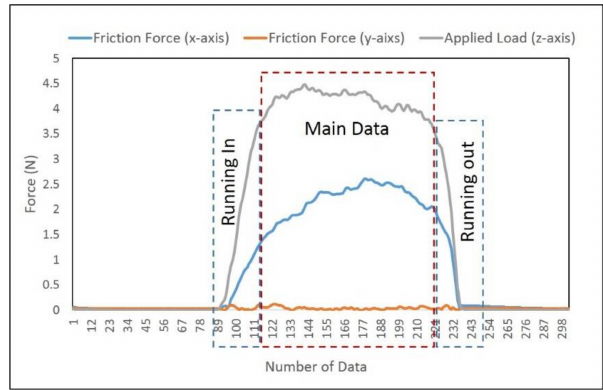
Figure 3. Force measurement of a single stroke.